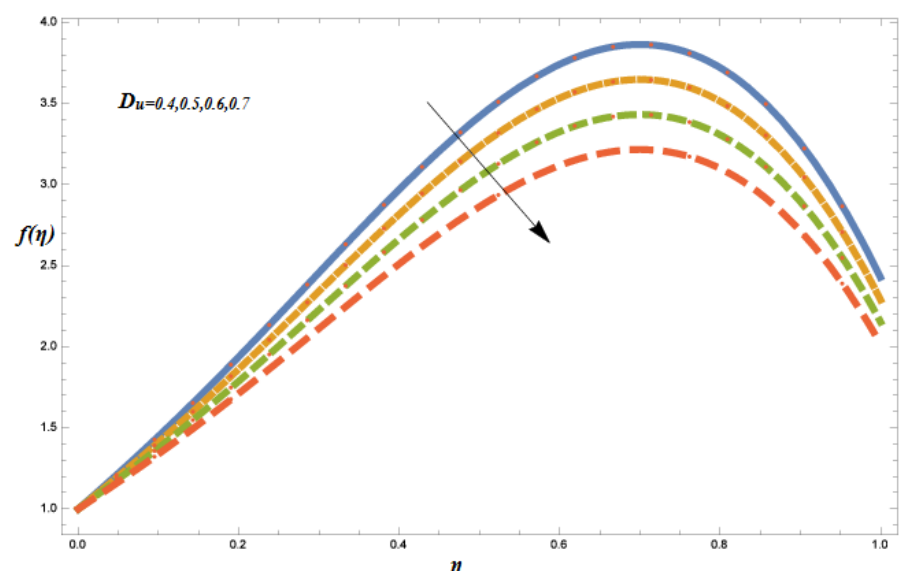
D , when  = − 0.25, P r = 10, S c = u